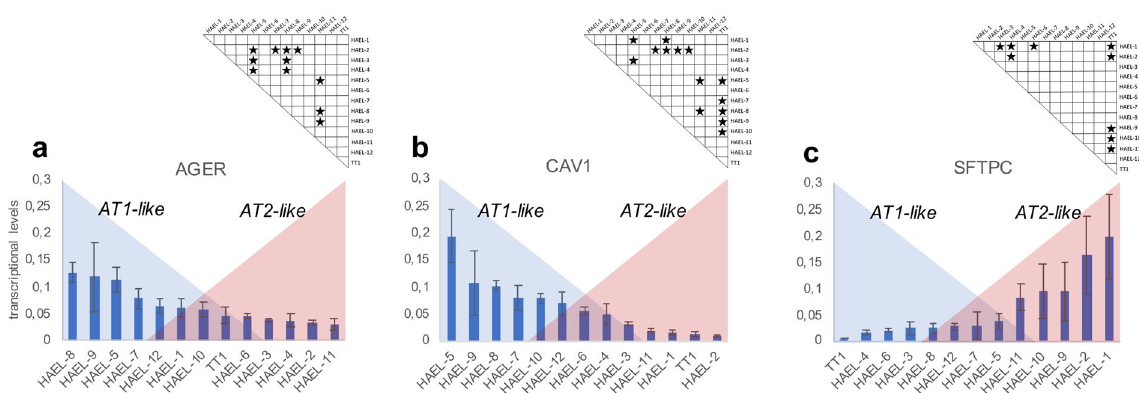
Figure 2. Relative transcript levels of RAGE ( a ), caveolin-1 ( b ) and SP-C ( c ) in ICs and TT1 cell line. Values are given as means ± SD. Stars indicate significant differences (p < 0.05) among groups according to the Kruskal– Wallis followed by the Dunn’s post hoc test. n = 6 replicates per